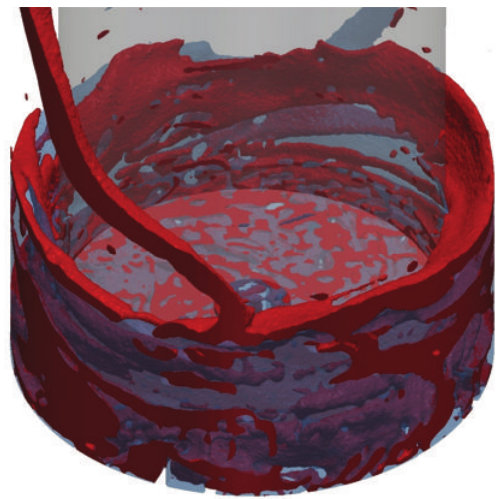
Figure 9: Snapshot of liquid phases for liquid-liquid-air simulation of a contactor mixing zone using VOF interface capturing methods taken from Wardle, [145]. Water is shown as transparent blue and oil is red while the air is not